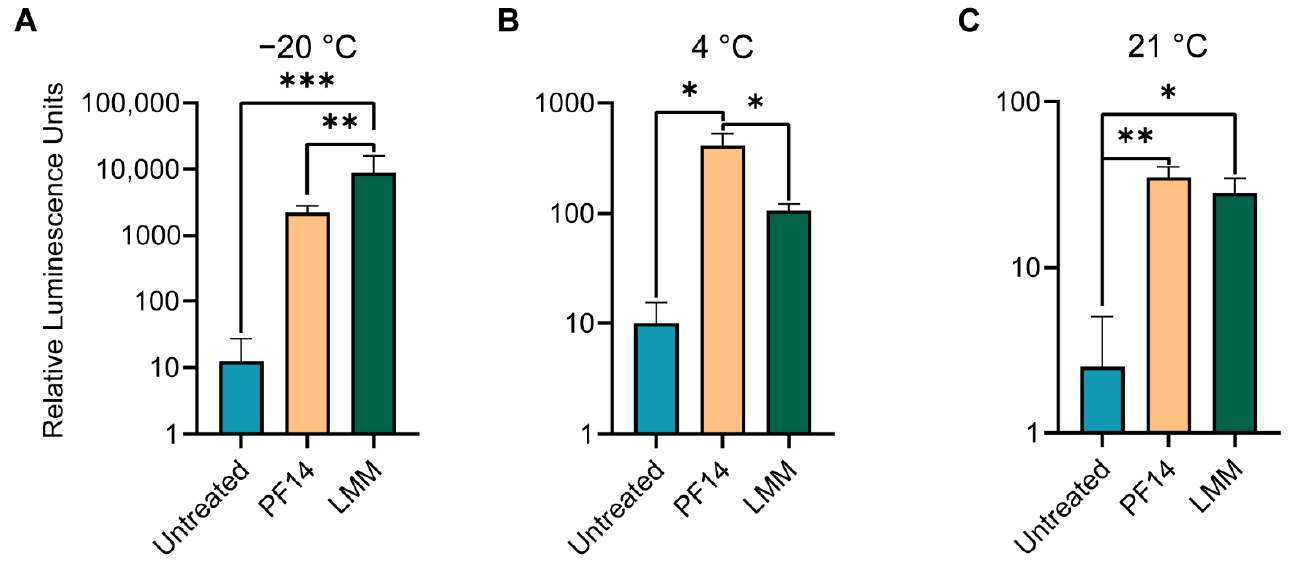
Figure 5. The effects of storage temperature on transfection of mRNA-functionalized collagen scaffolds. MC3T3 cells were seeded onto scaffolds containing PF14-SecNLuc mRNA (536 ng mRNA/scaffold), or LMM-formulated mRNA at equivalent dose. Before seeding, all collagen scaffolds had been stored at the indicated temperatures for 2 weeks in a sealed 24-well plate, pro- tected from light. ( A ) Merged quantification of secreted and sequestered nanoluciferase in 3D collagen scaffolds stored for 2 weeks at − 20 ◦ C, ( B ) 4 ◦ C, ( C ) and at 21 ◦ C. Values represent the mean + SEM of three biological replicates (two for untreated conditions), *: p ≤ 0.05, **: p ≤ 0.01, ***: p ≤ 0.001. PF14: PepFect14, LMM: Lipofectamine